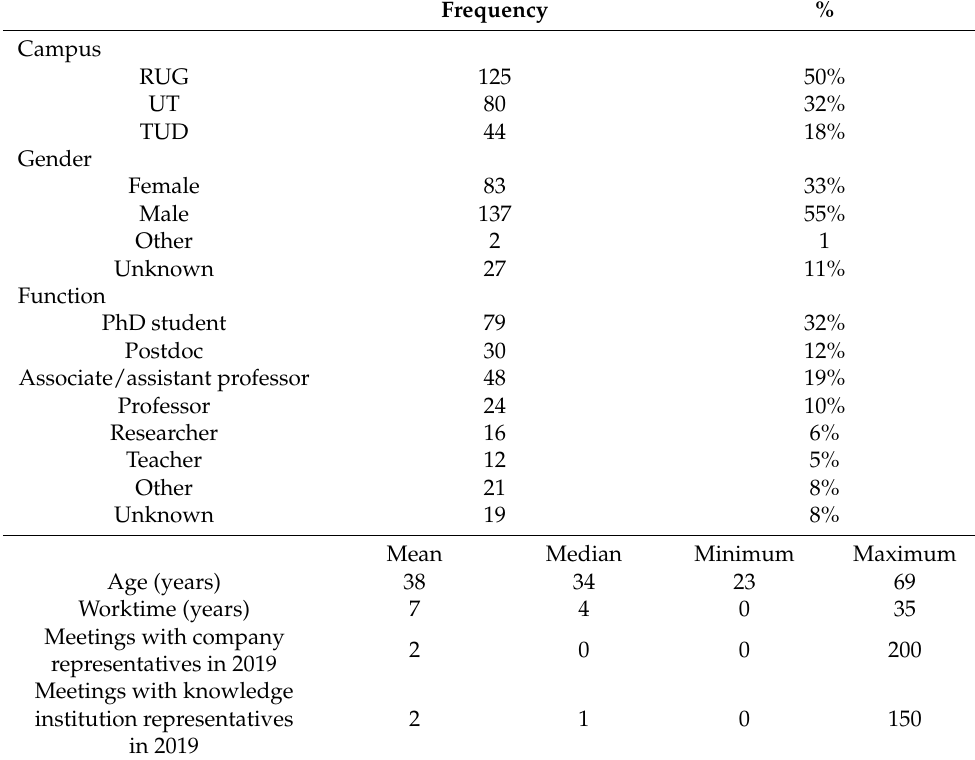
Table 7. Respondent characteristics for